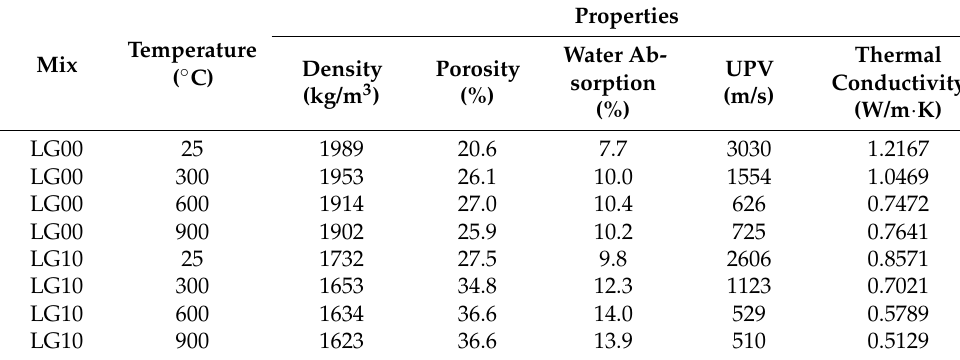
Table 6. Density, porosity, water absorption, UPV, and thermal conductivity of LG00 and LG10 after exposure to elevated